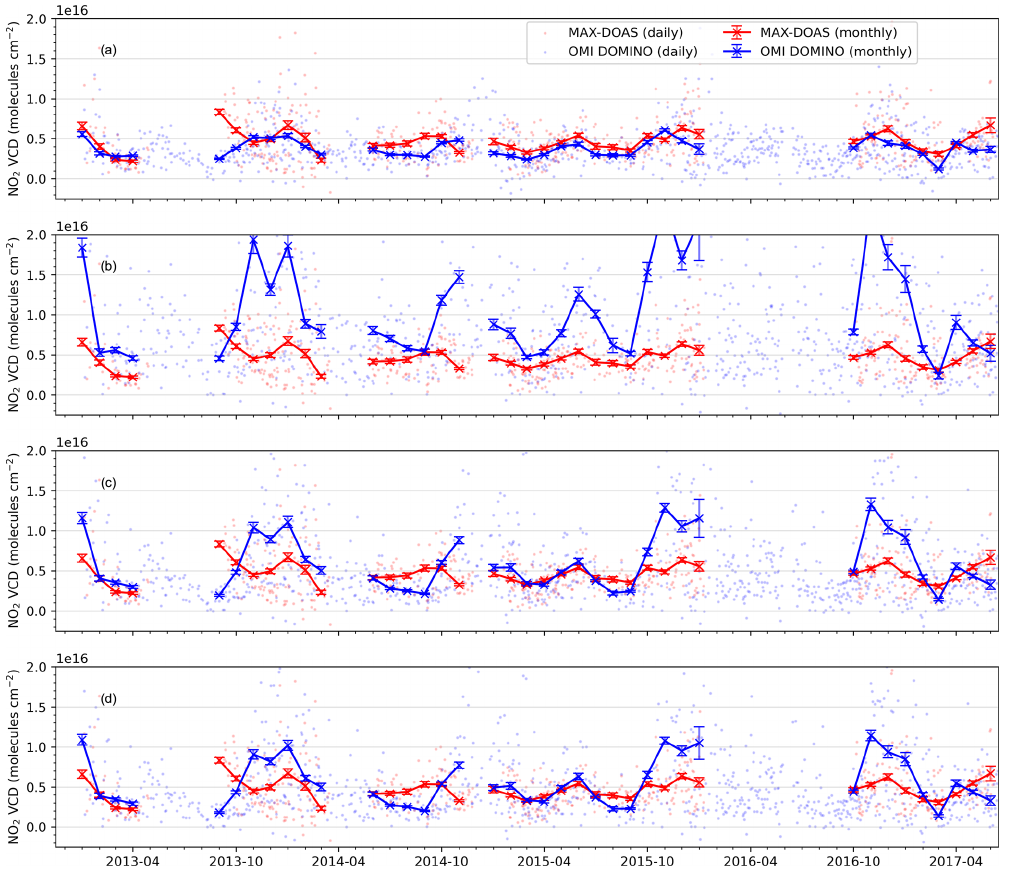
Figure D3. Time series of the MAX-DOAS and OMI DOMINO NO 2 tropospheric VCDs for (a) when no modifications in the a priori profiles are applied, (b) when the a priori profiles of DOMINO are replaced by the MAX-DOAS profiles, (c) when the lowest 5km of the profiles of the a priori are replaced by the corresponding MAX-DOAS profiles, and (d) when the lowest 2.5km of the profiles of the a priori are replaced by the corresponding MAX-DOAS